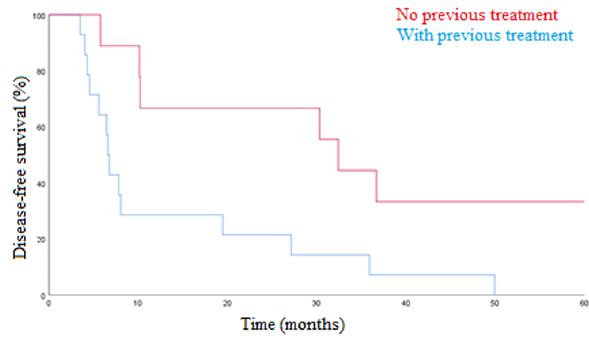
Figure 2 - Kaplan Meier curves of disease-free survival, with the previous treatment as comparison factor